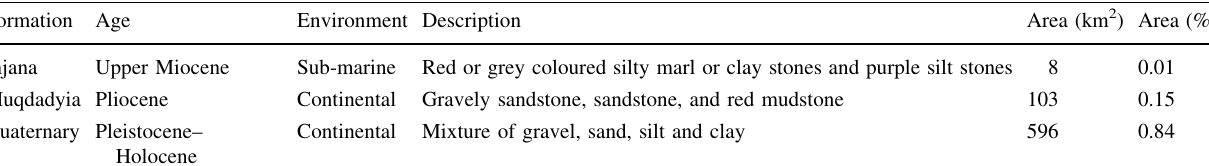
Fig. 4 Box and whisker plot for the